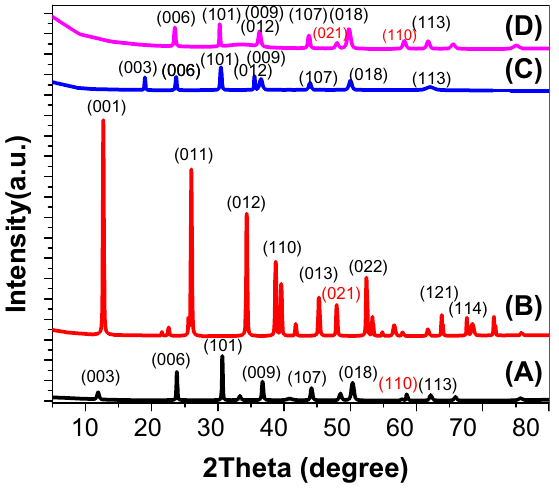
Figure 1. XRD of Co–Cd–Fe LDH ( A ), PbI 2 ( B ), and T-LDH/PbI 2 ( C ). T-LDH/PbI 2 NC after ten runs in PEC ( D